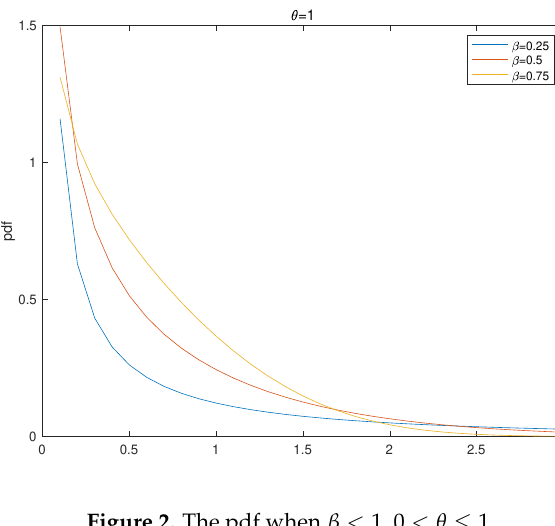
Figure 2. The pdf when β < 1, 0 < θ ≤ 1.